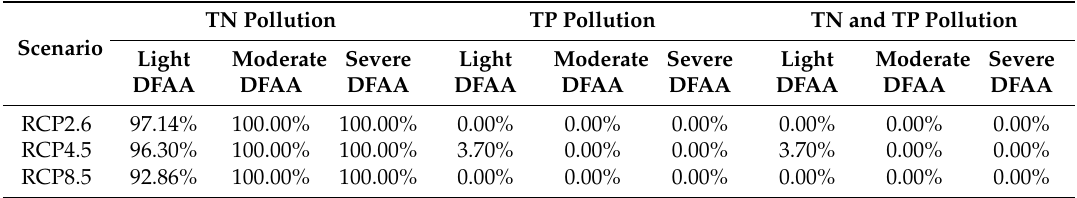
Table 8. The incidence of water pollution (%) in Class IV under different DFAA